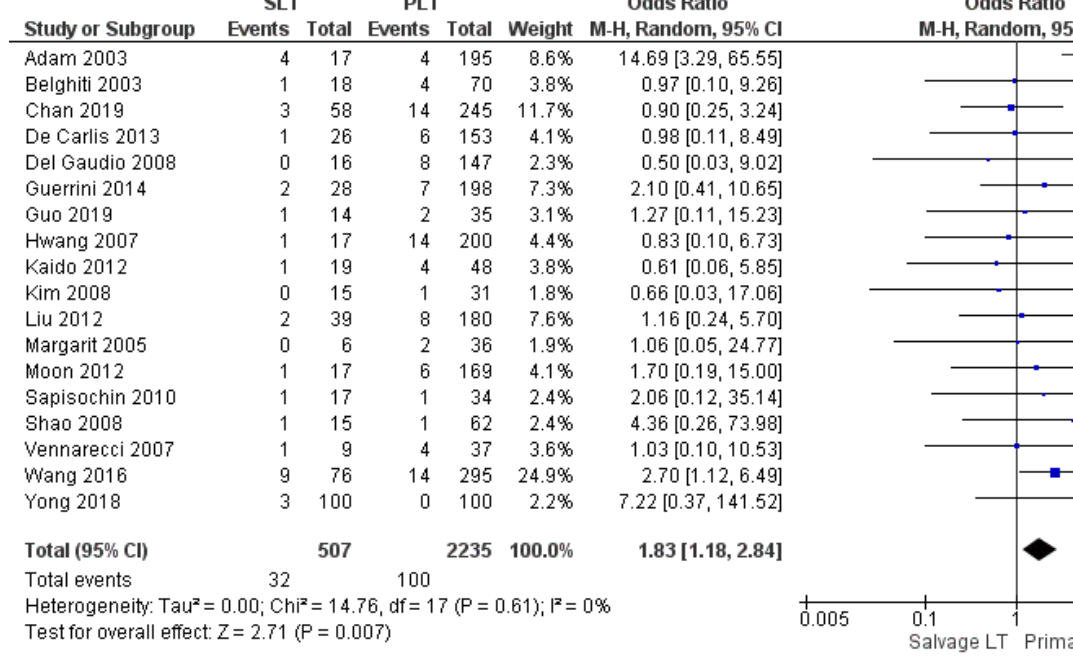
Figure 7. Perioperative mortality rate.